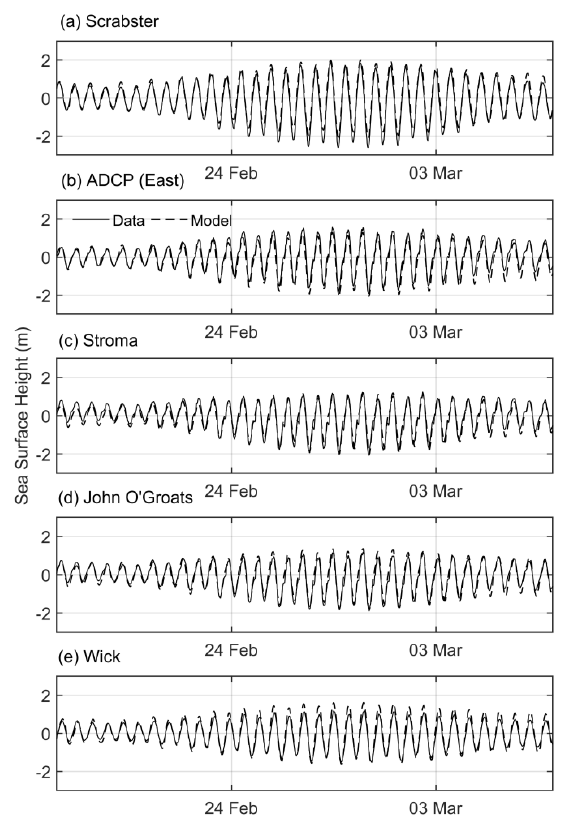
Figure 5. Model-predicted sea surface height (SSH) over the first 17 days of the calibration simulation, with a drag coefficient of C D = 0.004. Results are compared to the observed SSH at five measurement sites (Figure 1). ( a ) Scrabster; ( b ) ADCP (East); ( c ) Stroma; ( d ) John O’Groats; and ( e ) Wick. Table 4. Modelled and observed amplitude ( A , m) and phase ( G , ° relative to coordinated universal time (UTC) of the tidal height for the five principal tidal constituents at five locations around the Pentland Firth (Figure 1).